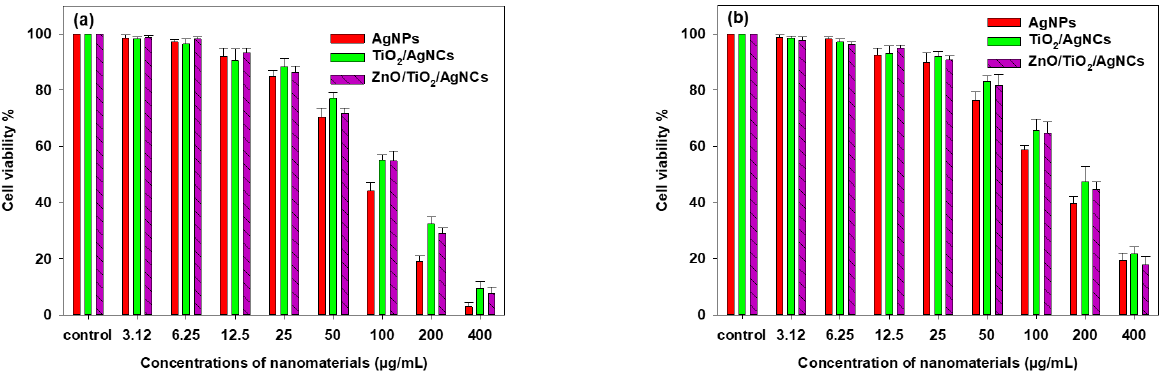
Figure 9. MTT cytotoxicity of AgNPs, TiO 2 /AgNCs and ZnO/TiO 2 /AgNCs against A549 lung cancer cells ( a ) and RAW264.7 macrophage cells ( b ).